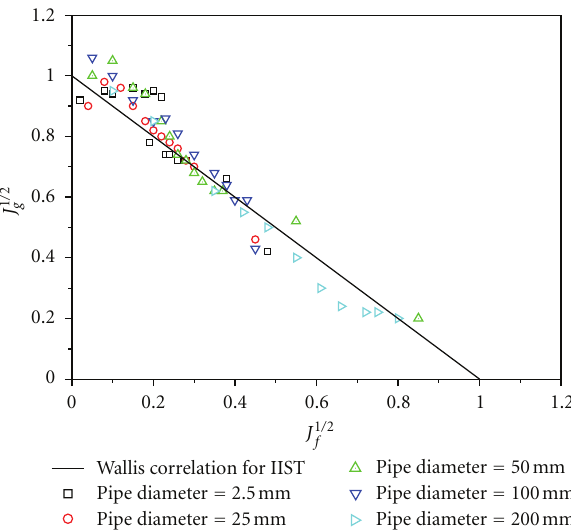
Figure 2: The Wallis correlation comparison with data (pipe diameter = 2.5–200 mm).